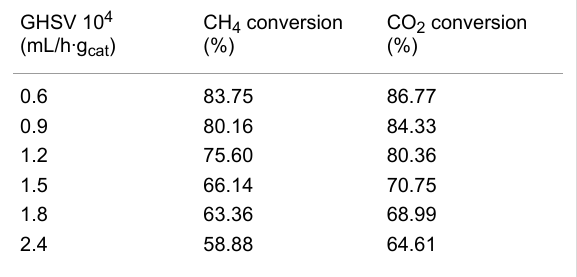
Table 7: Effect of gas hourly space velocity (GHSV) on the activity of a 10 wt % Ni/MgO catalyst in DRM reaction at 700 °C and molar ratio of CH 4 /CO 2 1:1 [108].